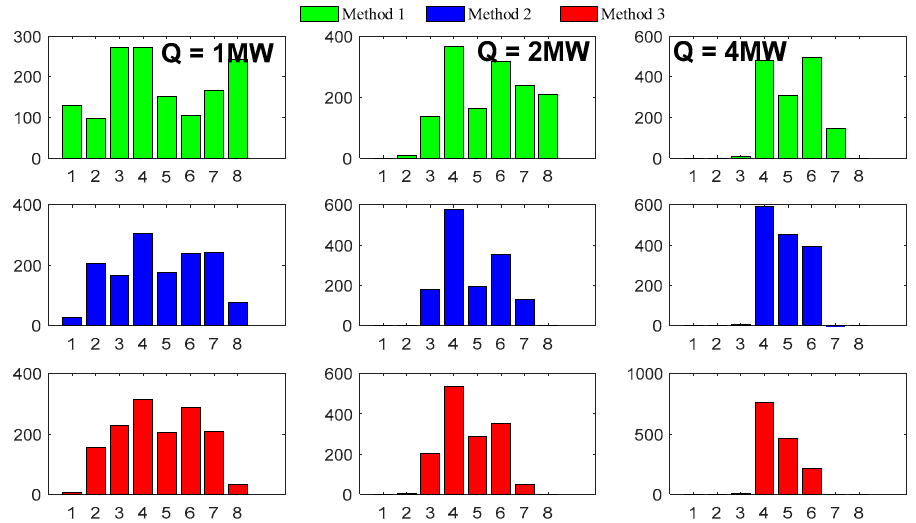
Figure 14. Frequency distribution histograms for different energy storage SOE intervals under different Q during a typical day. Table 6. Assessment criteria under different Q .